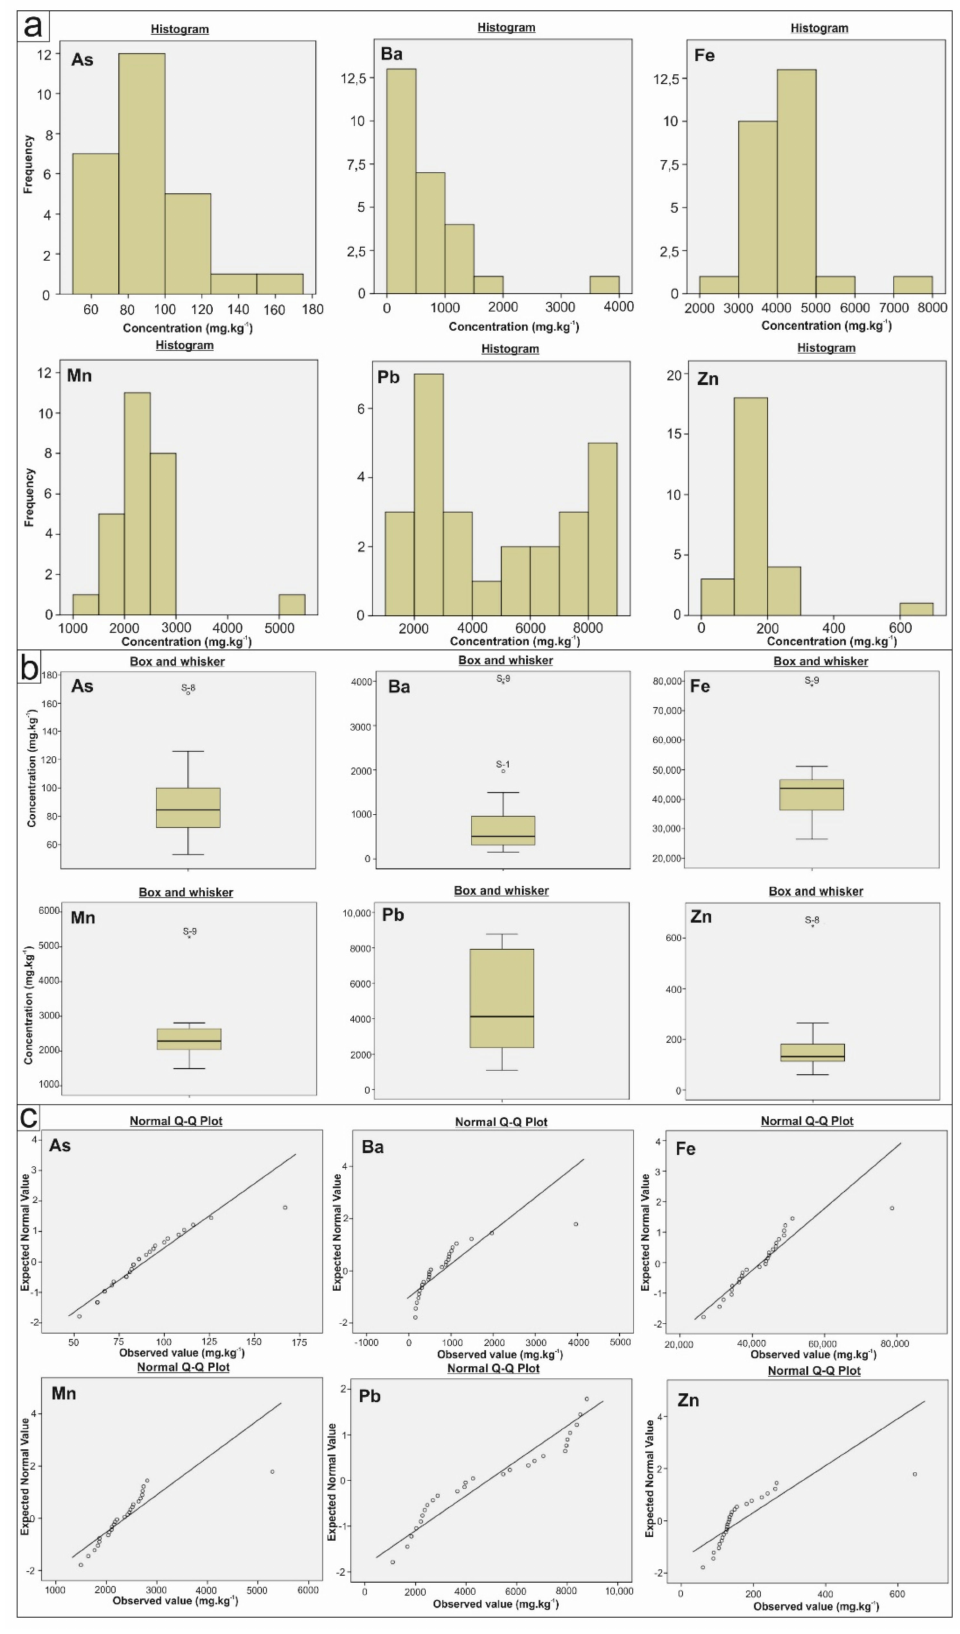
Figure 5. Univariate statistics: ( a ) histograms, ( b ) box-and-whisker plots, and ( c ) normal Q-Q plots for the concentration of metals along the slope of the tailing